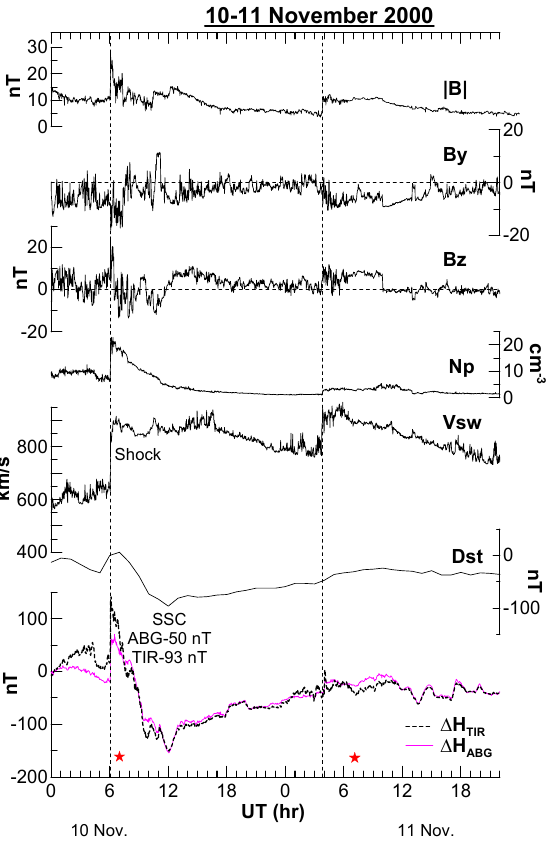
Fig. 6. From top to bottom: IMF | B | , IMF B y , IMF B z , proton density ( N p ), solar wind speed ( V sw ), hourly averaged D st index, 1-min digital magnetic data 1H ABG and 1H TIR for 10–11 Novem- ber 2000. Red star (*) depicts local